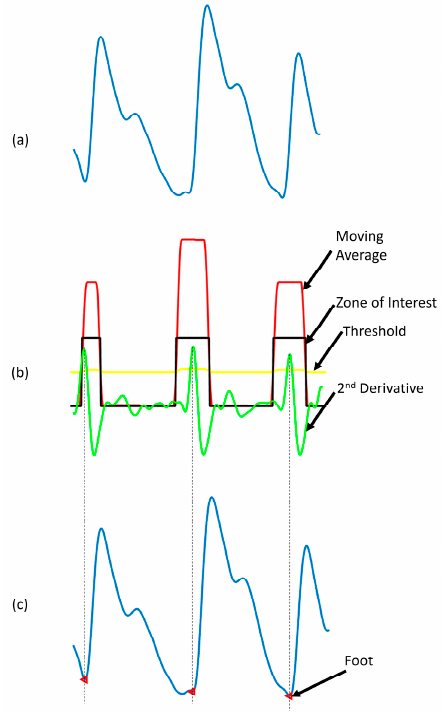
Figure 10. Detection of the foot of a PPG waveform. ( a ) Filtered PPG signal; ( b ) second derivative of PPG along with derivation of the zone of interest based on moving average of acceleration plethysmogram (APG) and adaptive threshold; ( c ) foot of the signal detected.